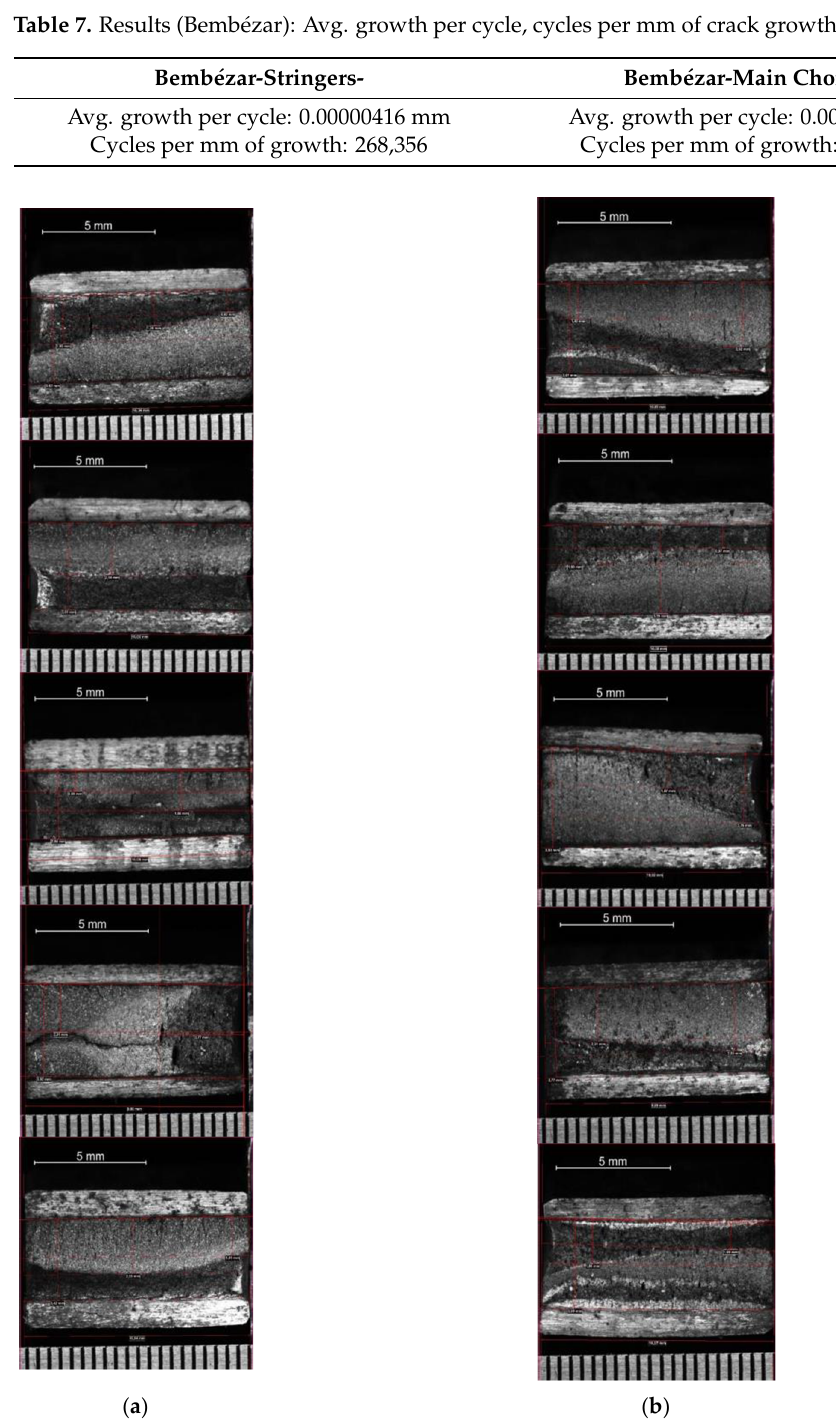
Figure 14. Sample fractography ( a ) Corbones Stringers; ( b ) Corbones Main Chords.